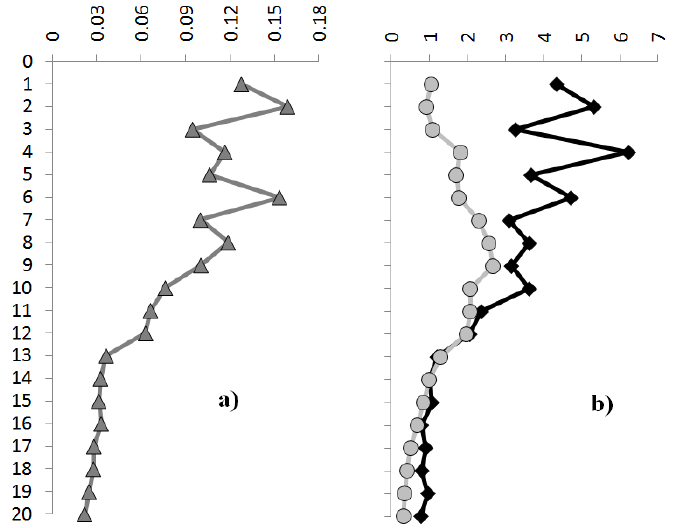
Figure 1. Concentrations (ng/g dw) of ( a ) hexachlorobenzene (HCB) (triangles); ∑ polychlorobiphenyls (PCBs) (sum of #52, #101, #118, #153, #138, #180; black squares)